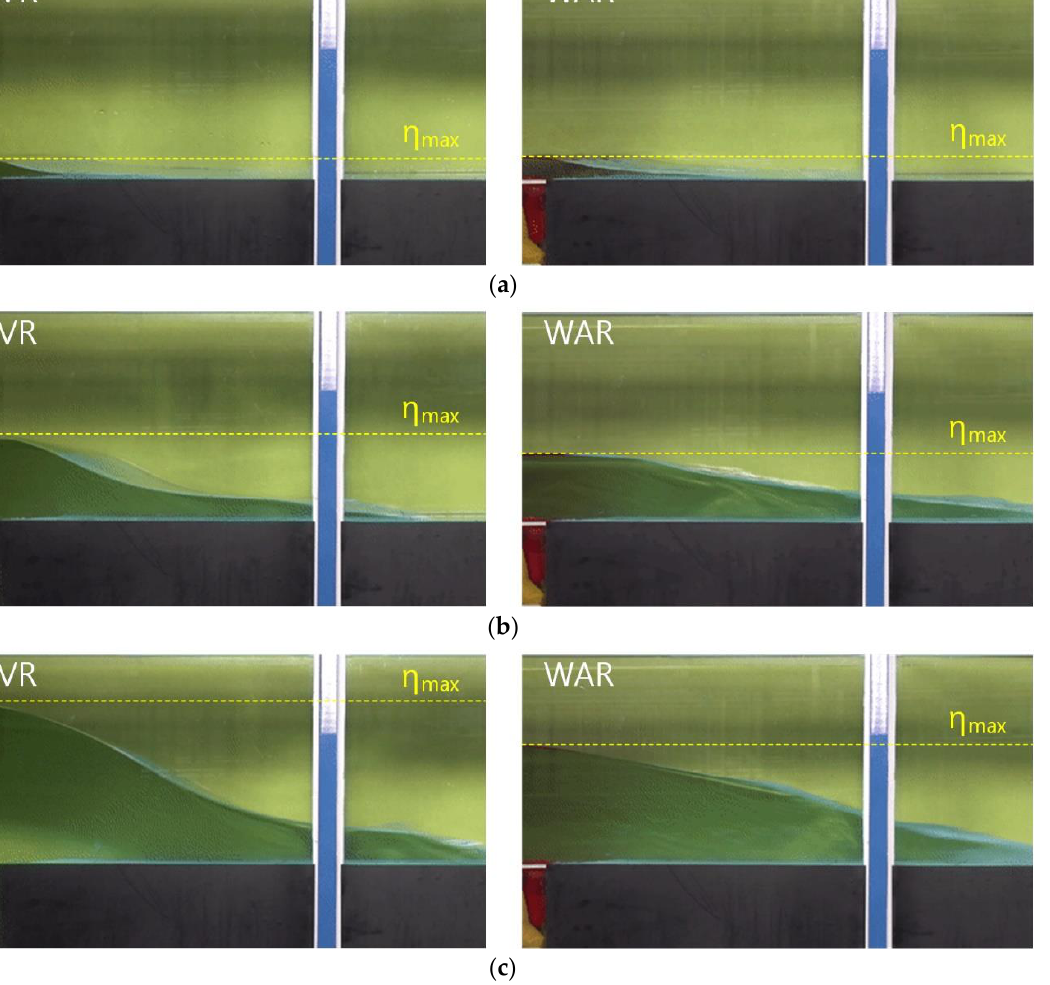
Figure 3. Comparisons of time-domain waveforms at the front of the VR and WAR. Overtopping of the solitary waves was observed in Run-7 and Run-11 under the con- dition 𝐴 0 > 𝐹 𝑏 , for which overtopping was expected to occur. As evidenced in Figures 2a and 3a, overtopping occurs in both the VR and WAR even under the 𝐴 0 < 𝐹 𝑏 condition of Run-1. At the maximum water surface elevation during overtopping, the difference between the two maximum water surface elevations in Figure 2a, where 𝜀 is the smallest, is not large. However, as 𝜀 increases, the difference between the maximum water surface elevations at the VR and WAR increases. Lee et al. [33] analyzed the main cause of this trend through experiments and numerical analysis, which can be explained as follows. At the VR, because of a sharp decrease in the flow cross-sectional area, the horizontal velocity of the solitary wave is converted to vertical velocity, and overtopping occurs as the water surface elevation rises. Because the effective wavelength shortens as ε in- creases, the vertical velocity develops further, and the water surface elevation rises sub- stantially during overtopping. Conversely, at the WAR, the flow cross-sectional area grad- ually decreases along the inclined wave absorber in front of the vertical wall. Thus, for the solitary wave passing through the inclined wave absorber, the horizontal and vertical ve- locities both develop along the slope, and the horizontal velocity becomes dominant above the crest. As a result, the rise in water surface elevation during solitary wave overtopping at the WAR does not exceed that at the VR; this trend is shown in Figure 4, which com- pares the dimensionless maximum water surface elevation ( 𝜂 max /ℎ ) measured at WG2 in front of the vertical wall. Figure 4 shows a clear trend where 𝜂 max /ℎ increases as ε in- creases, and the gradient is steeper at the VR than at the WAR. When 𝜀 is small, 𝜂 max /ℎ at the VR and WAR does not show a difference, but the difference in 𝜂 max /ℎ increases as 𝜀 increases.